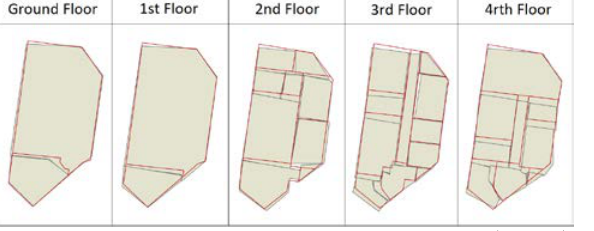
Figure 9. Comparison between the digitized polygons (in grey) and the reference data (in red), for each one of the studied building floors